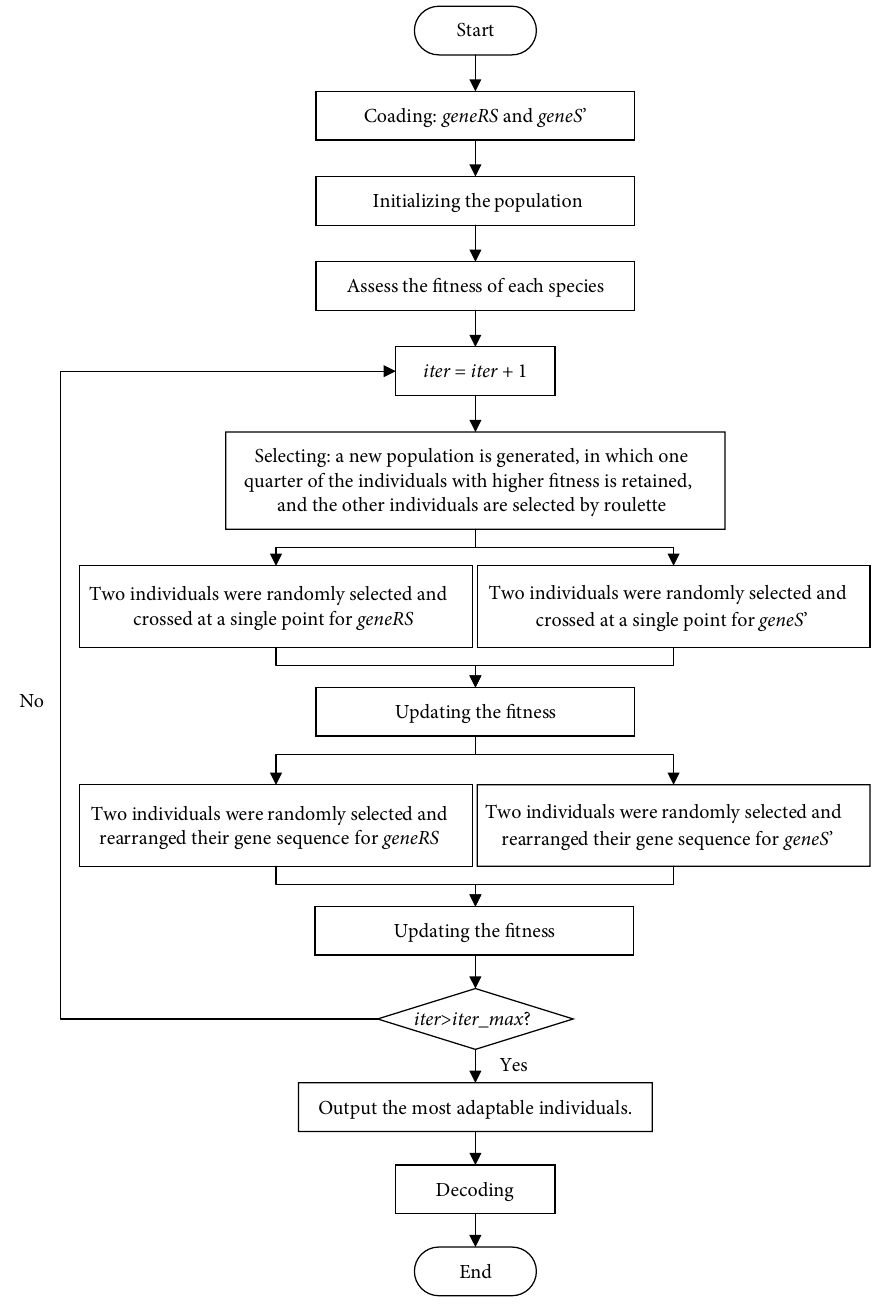
Figure 7: The flow chart genetic